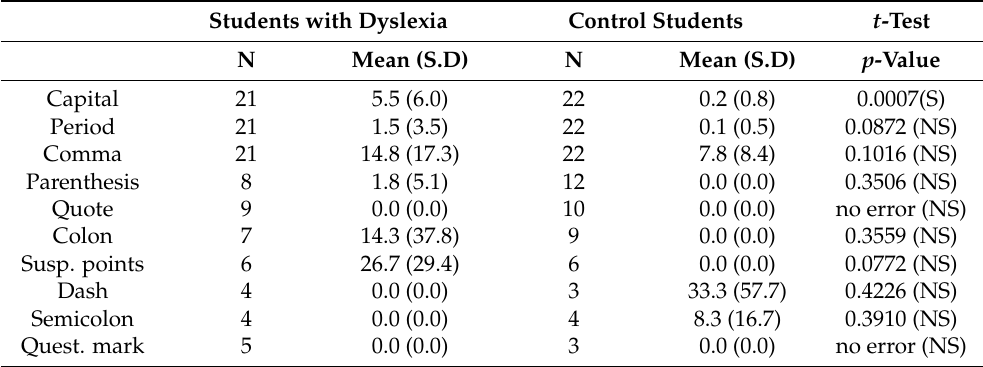
Table 9. Insertion rates for each category of punctuation (mean, SD, and Welch p -value: NS = non significant/S =